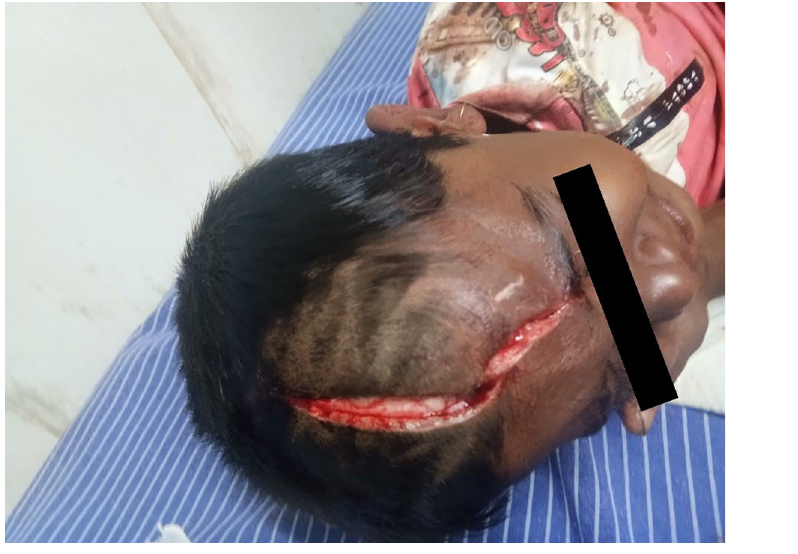
Fig 1. Category-III wound on the